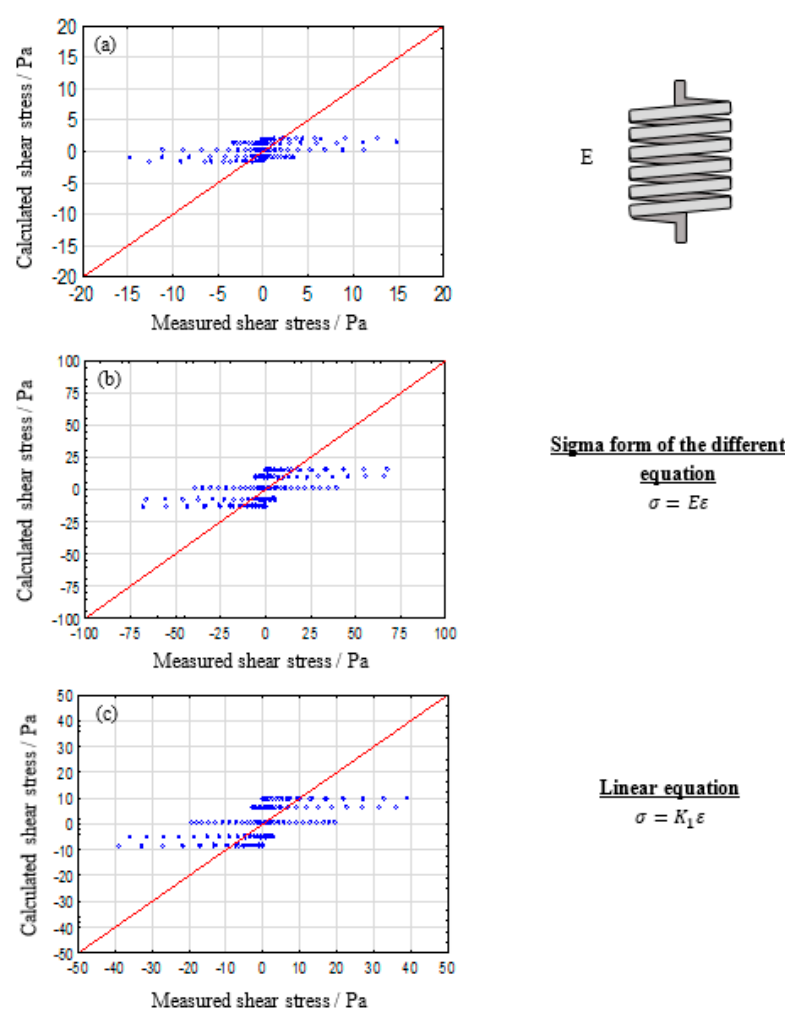
Figure 1. Calculated vs. measured shear stresses plot for a simple spring for describing the viscoelastic properties of 2% ( a ), 5% ( b ), and 8% ( c ) alginate solutions.